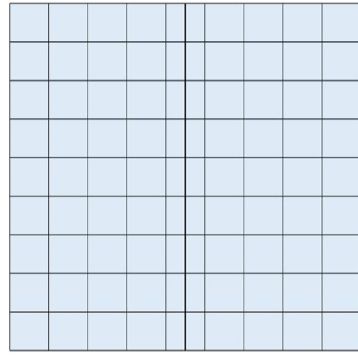
Fig. 11 Finite element mesh used in the analysis and unfitted interface